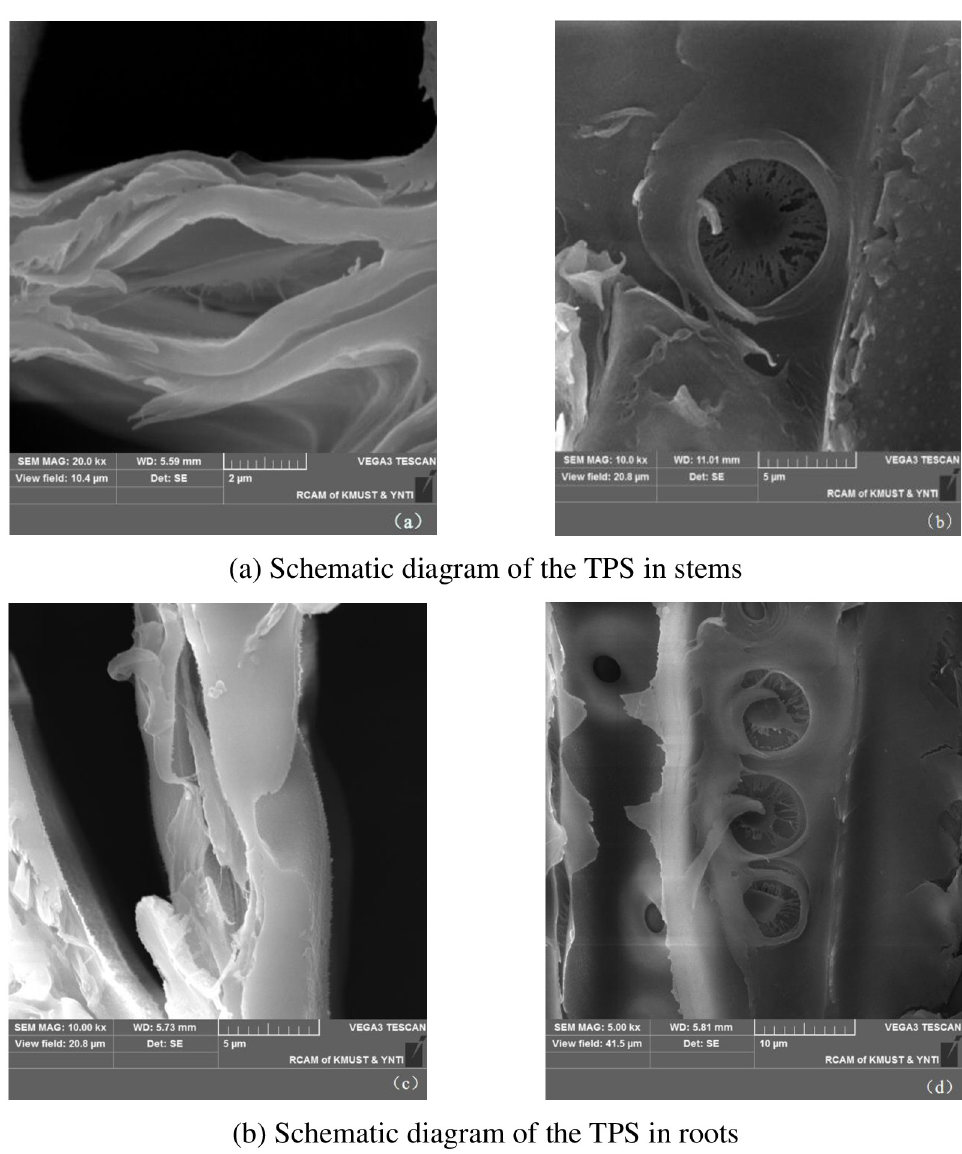
Fig 2. Schematic diagram of the TPS structure of the Sabina chinensis . (a) Schematic diagram of the TPS in stems. (b) Schematic diagram of the TPS in roots. distributed on the tracheid wall, the distance that water flow in the tracheid is the half of the tracheid length. Thus, water flowing through the single tracheid encounters two part resis- tances, which is tracheid lumen resistance and pit resistance. The tracheid lumen resistance ( R ) can be described by Hagen Poiseuille equation and was given by the expression l